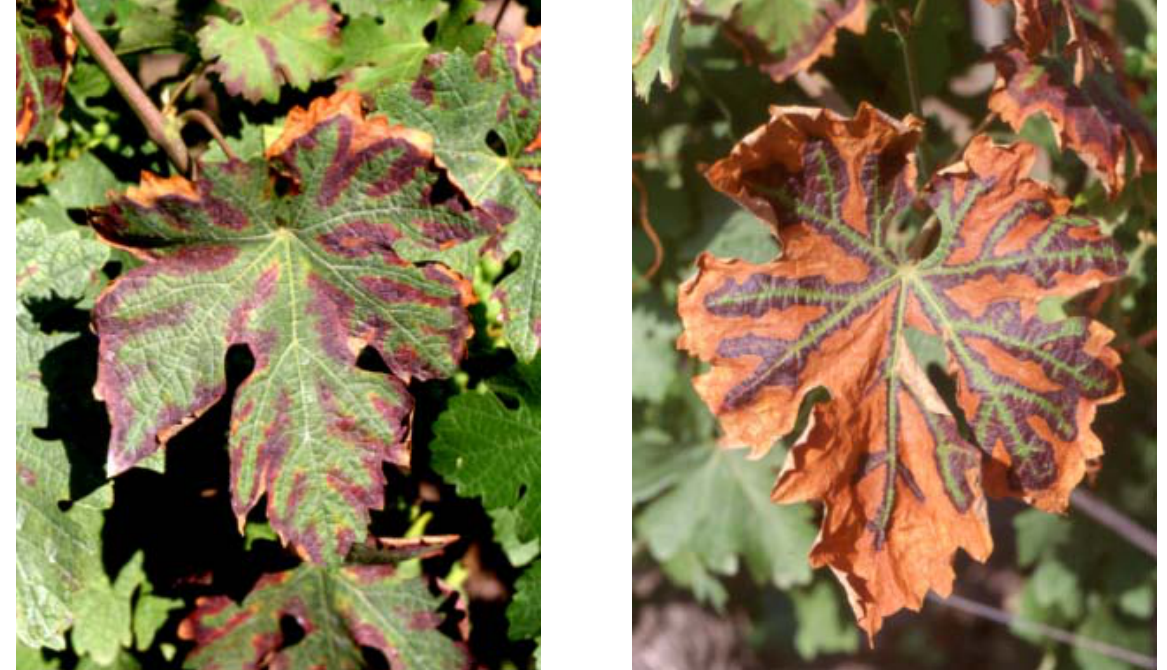
Fig. 2. Left and right, foliar symptoms of the mild form of black dead arm on Cabernet Sauvignon.